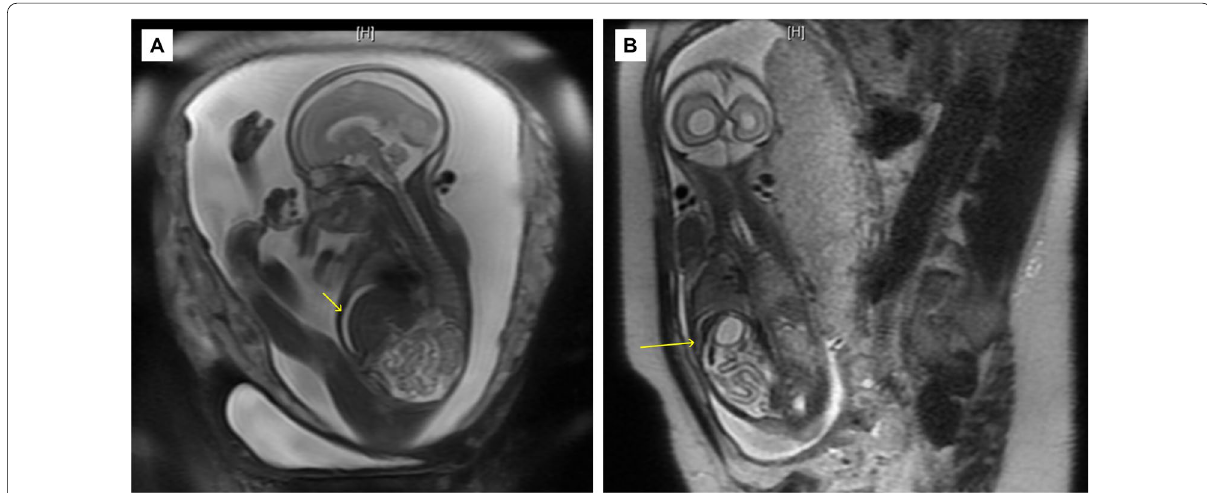
Fig. 2 Foetal magnetic resonance imaging (MRI) at 27 weeks of gestation. A : Axial MRI of fluid-filled loops of small bowels noted. There is a moderate volume of ascites with fluid overlying the liver (yellow arrow). B : Coronal MRI of a tubular structure containing high T1 signal at the inferior margin of the right hepatic lobe (yellow arrow). This is consistent with ascending colon atresia, stenosis, and/or perforation. There is no meconium visualised distal to this point. Mild cerebral ventricle asymmetry noted with no significant ventriculomegaly